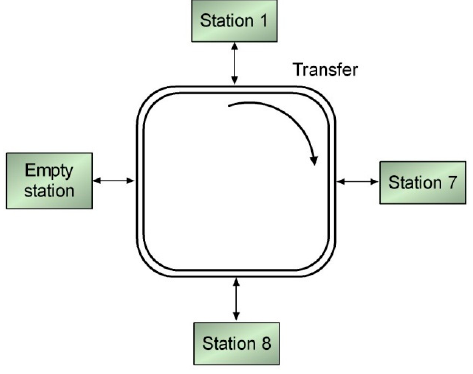
Figure 7. Block diagram of the layout of the stations.